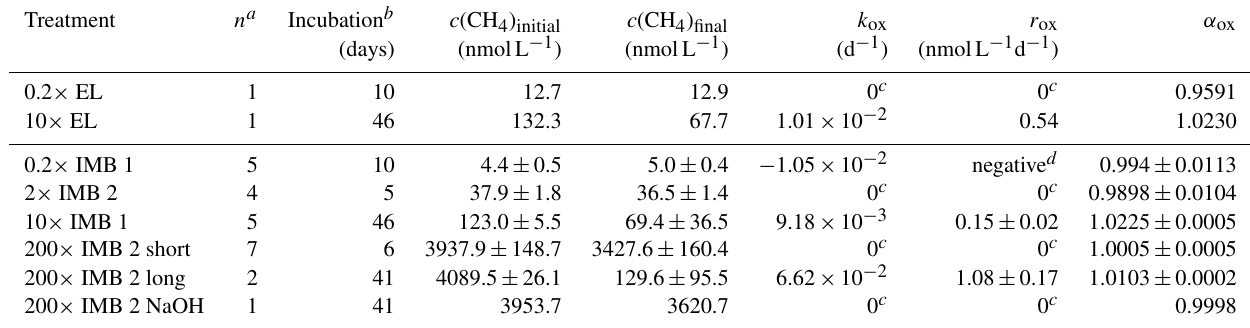
Table 3. Methane oxidation parameters during long-term incubation experiments. n : number of replicates, c (CH 4 ) initial : approximate initial methane concentration, k ox : net oxidation/production rate constant, r ox : net oxidation/production rate at in situ concentration, α ox : isotopic fractionation factor during oxidation. Oxidation rates and rate constants are replicated from Uhlig and Loose (2017a).